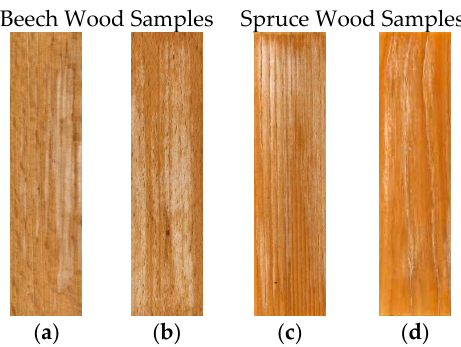
Figure 2. Oil-based coating after 6 weeks of AW. ( a ) Beech wood without pre-treatment (B-R-O); ( b ) beech wood with caffeine pre-treatment (B-5-O) achieved the best results from the tested oil-coated variants; ( c ) spruce wood without pre-treatment (S-R-O); ( d ) spruce wood with 10% FN-NANO ® treatment achieved the best results from the tested oil-coated variants (S-1-O).